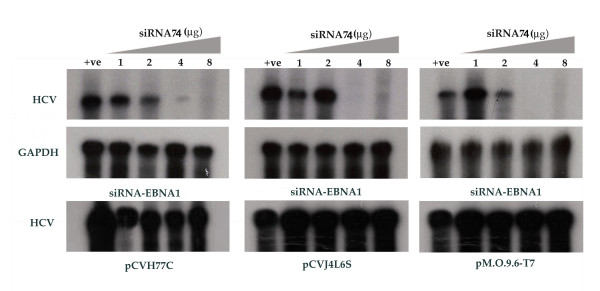
Ribonuclease protection assay showing siRNA expression specifically degraded intracellular HCV positive strand RNA in the transfected Huh-7 cells. Huh-7 cells were co-transfected with different concentration of siRNA74 with different full-length clones of HCV. After 48 hours, transfected cells were isolated by the treatment with trypsin-EDTA. Total RNA was isolated and subjected to RPA for positive strand HCV using a minus strand RNA probe targeted to the 5'UTR region. The degradation of HCV positive strand by siRNA74 is concentration dependent. No HCV RNA degradation was observed in the cells transfected with unrelated siRNA.